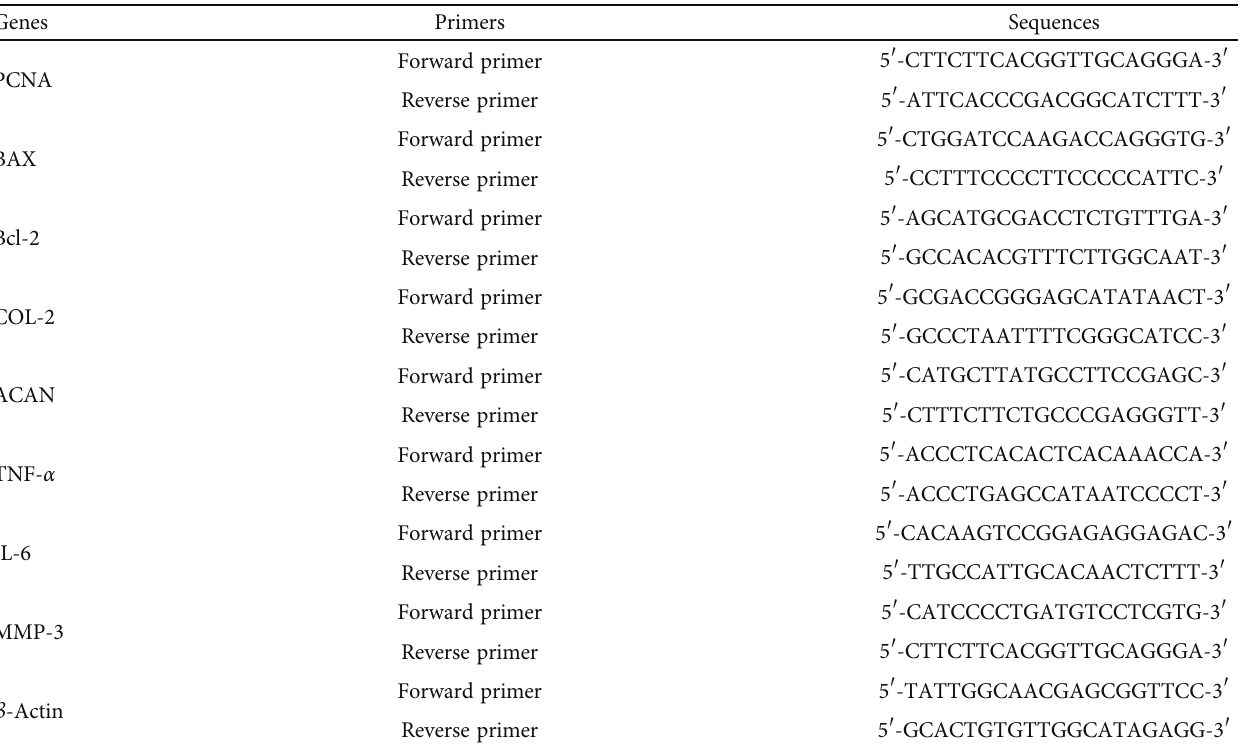
Table 1: Primers of the genes in this